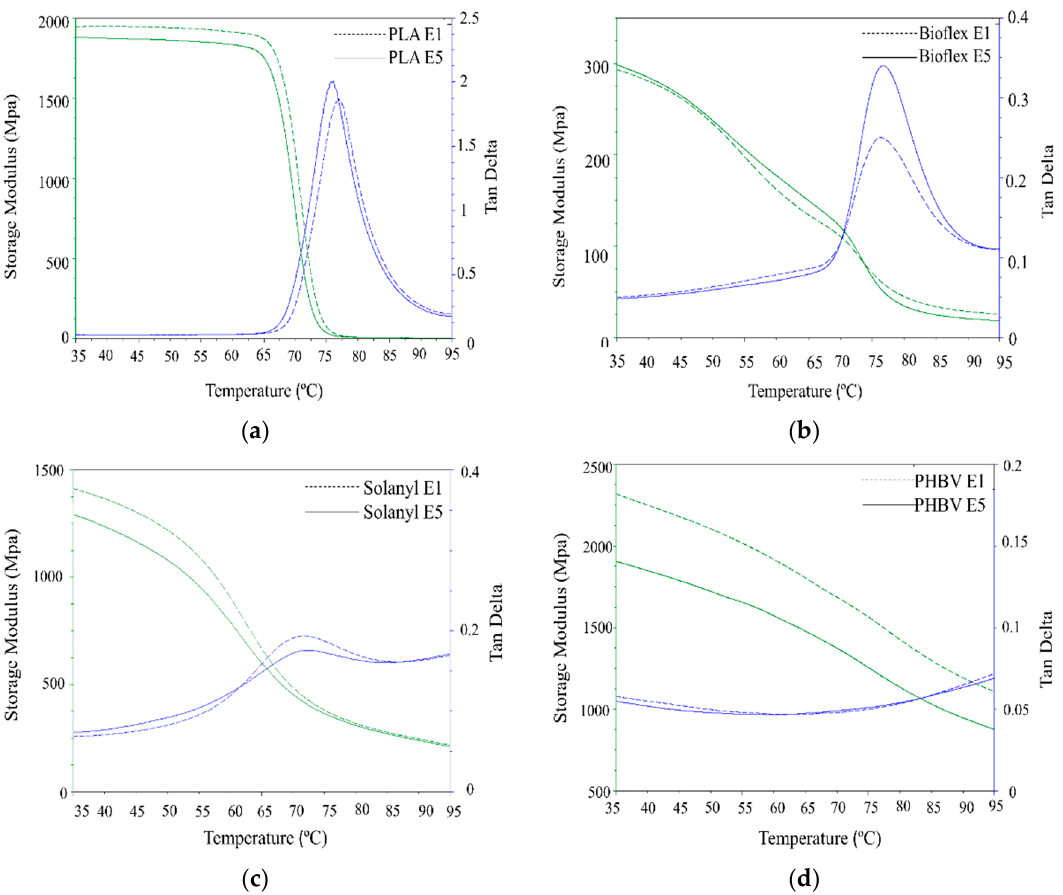
Figure 6. DMA analysis curve of virgin (E1) and recycled (E5) polymers: ( a ) PLA; ( b ) Bioflex; ( c ) Solanyl; and ( d ) PHBV.